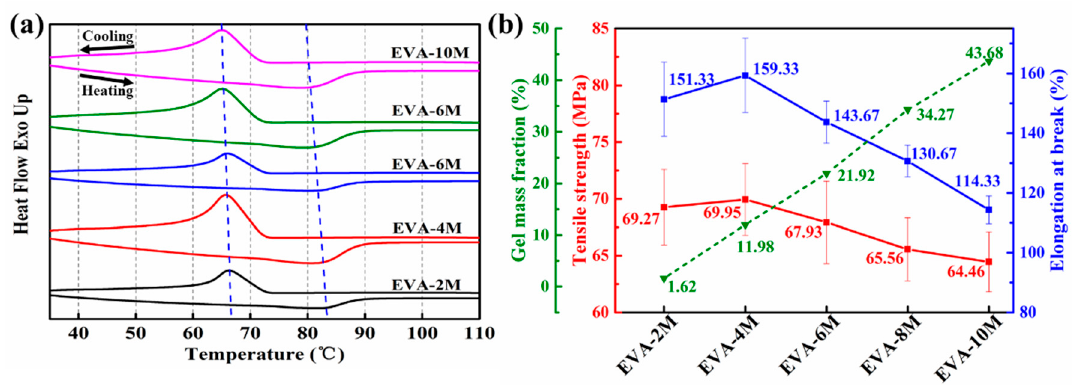
Figure 3. ( a ) DSC heating and cooling curves and ( b ) physical properties of different EVA fiber.